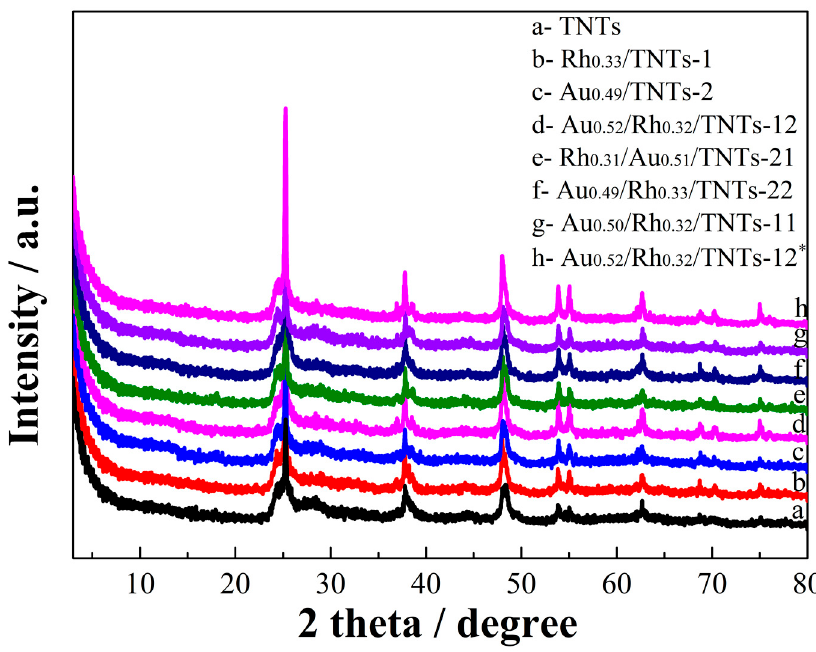
Figure 2. XRD patterns of the prepared catalysts.